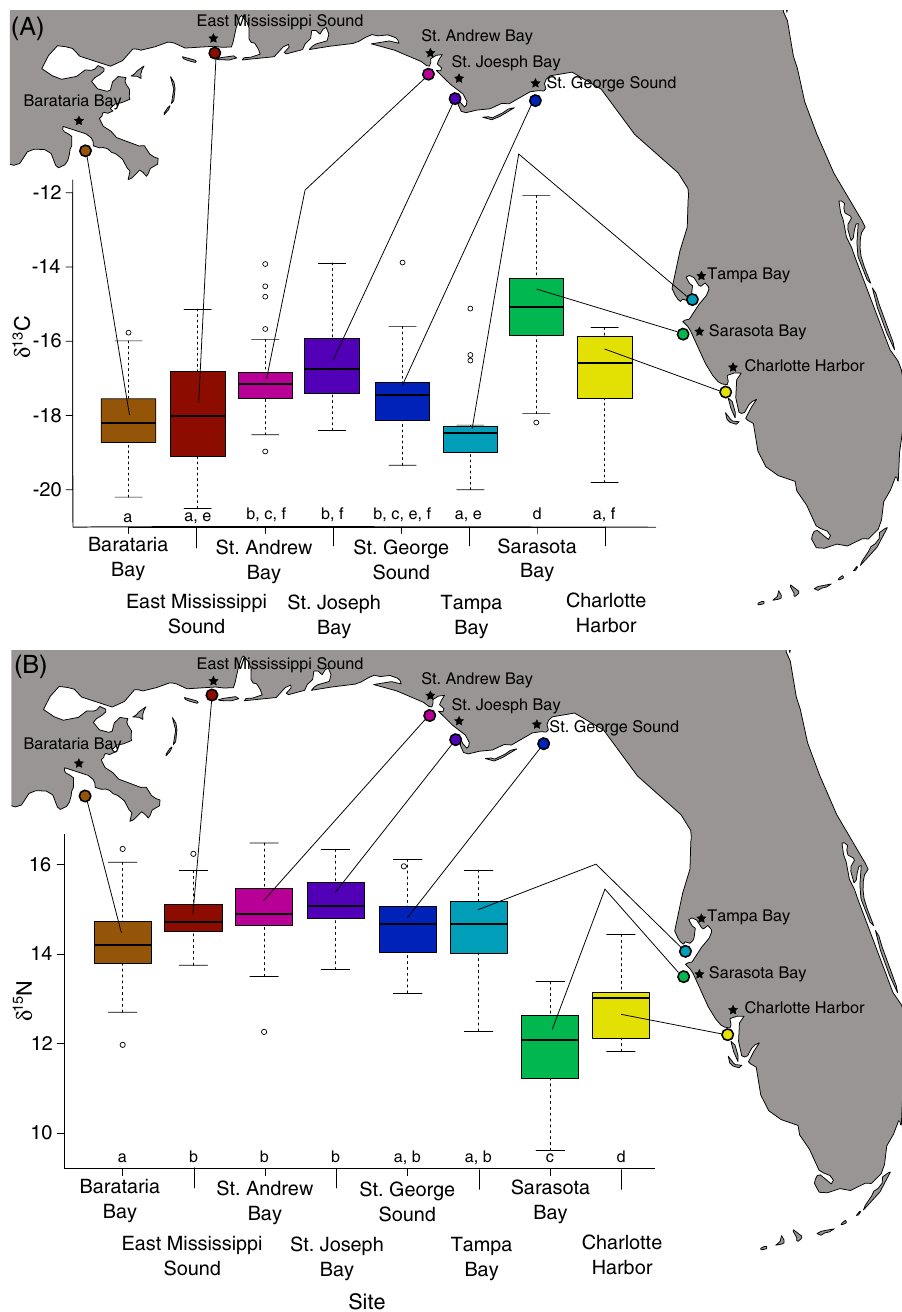
Figure 2. Among site variation in δ 13 C ( A ) and δ 15 N ( B ) values. Letters below boxplots indicate which sites are statistically similar . Maps were generated using the ggmap package (version 3.0.0) in R 106